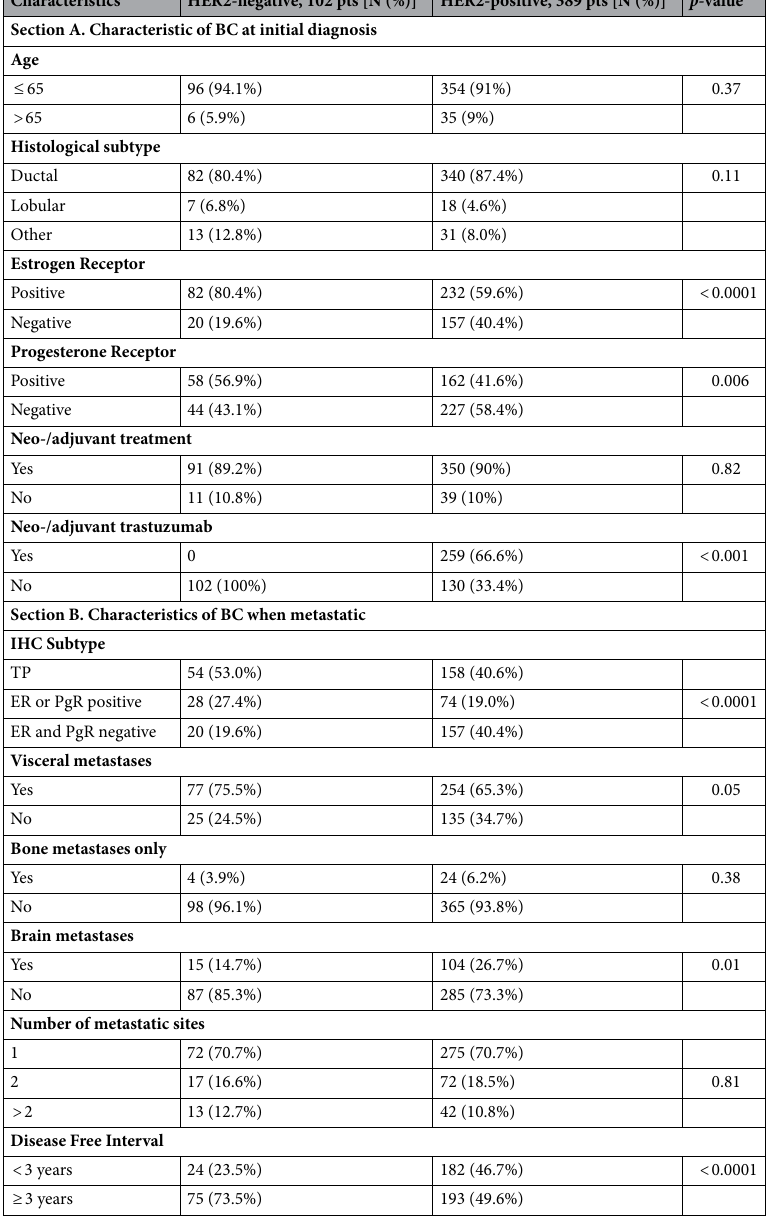
Table 1. Clinic-pathological characteristics of the study participants according to HER2 status at initial diagnosis (1A) and when metastatic (1B) (N:491). N, Number; BC, breast cancer; IHC, Immunohistochemical; TP, triple positive; ER, estrogen receptor; PgR, progesterone